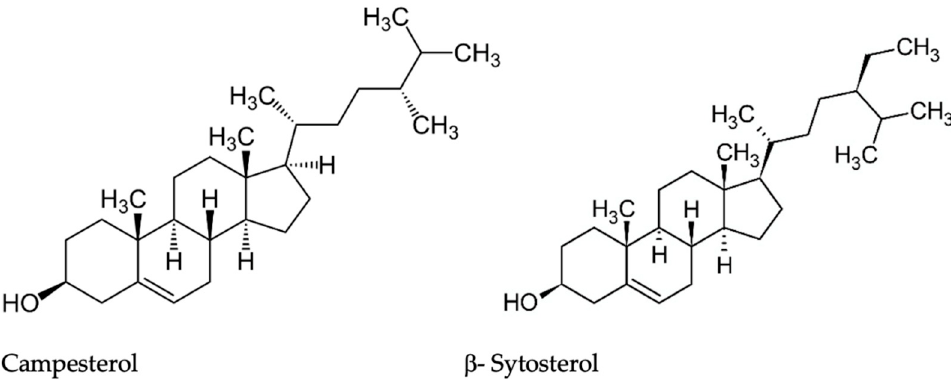
Figure 4. Structures of Campesterol and β -Sytosterol.